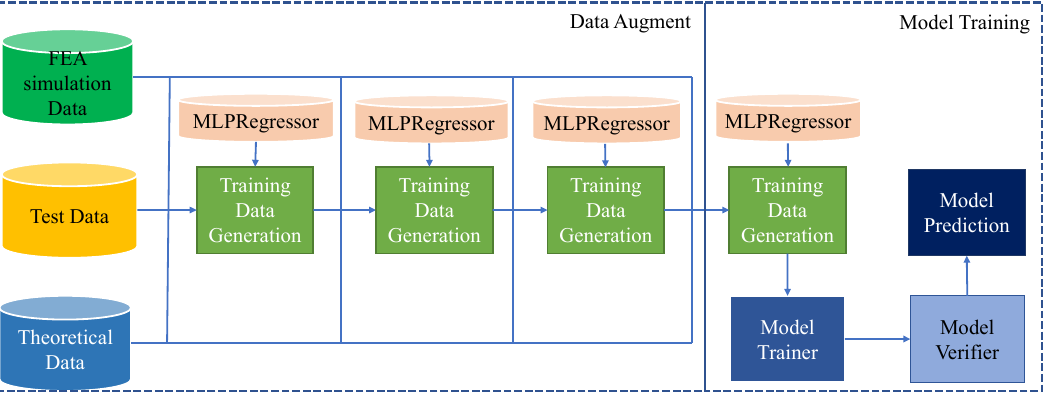
Figure 6. Data augmentation overview.